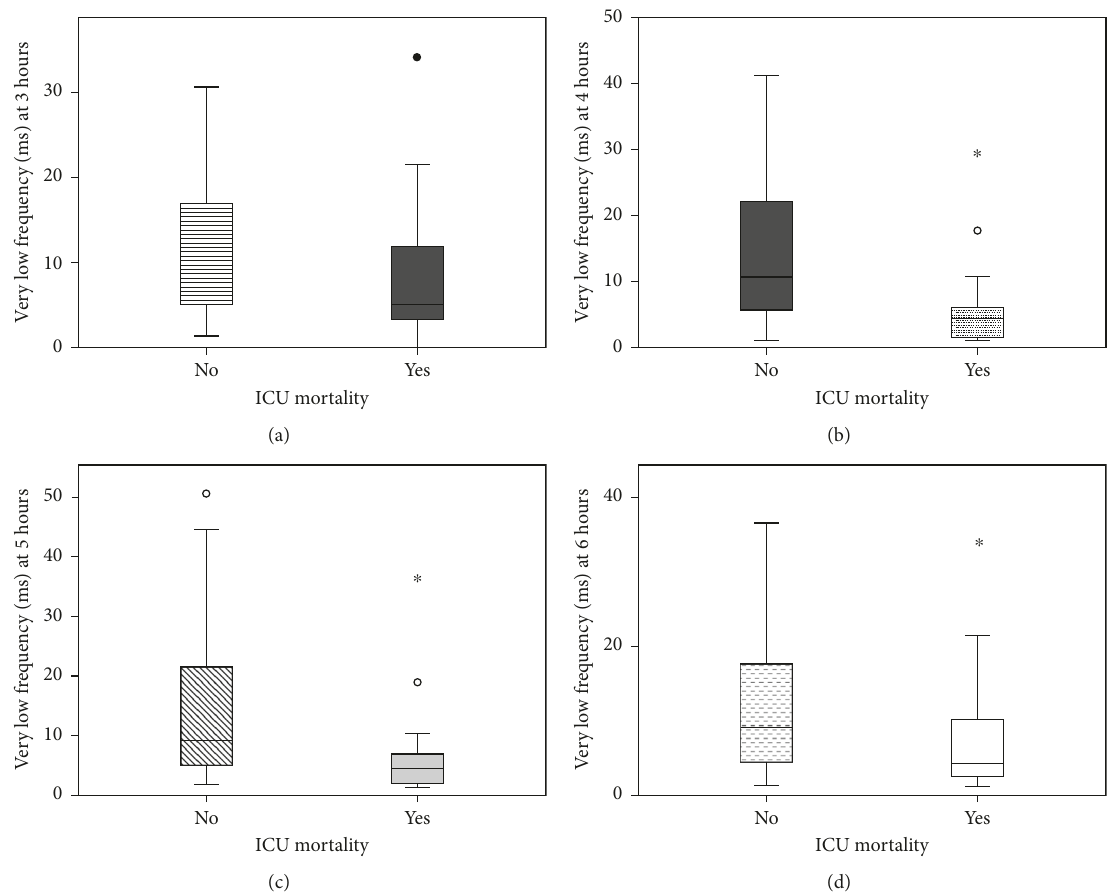
Figure 3: Trends in hourly very low frequencies between ICU survivors and